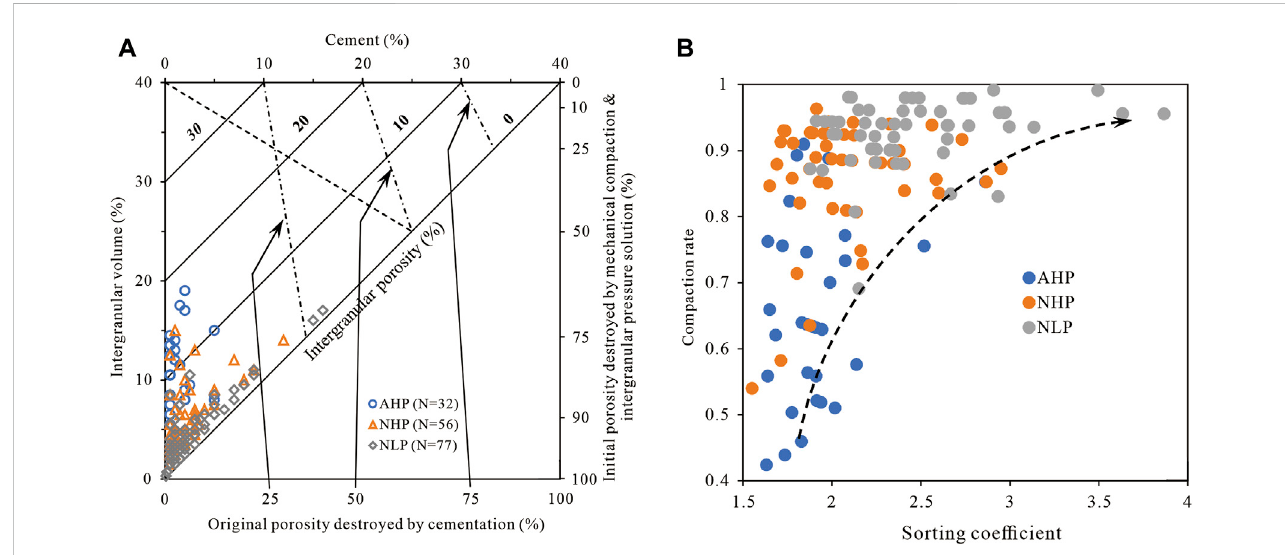
FIGURE 7 (A) Plot of the effect of compaction and cementation on porosity loss in the J 2 x 1+2 sandstones (modi fi ed from Houseknecht, 1987; Ehrenberg, 1989). (B) Cross-plot showing the relationship between the sorting coef fi cient and the compaction rate.